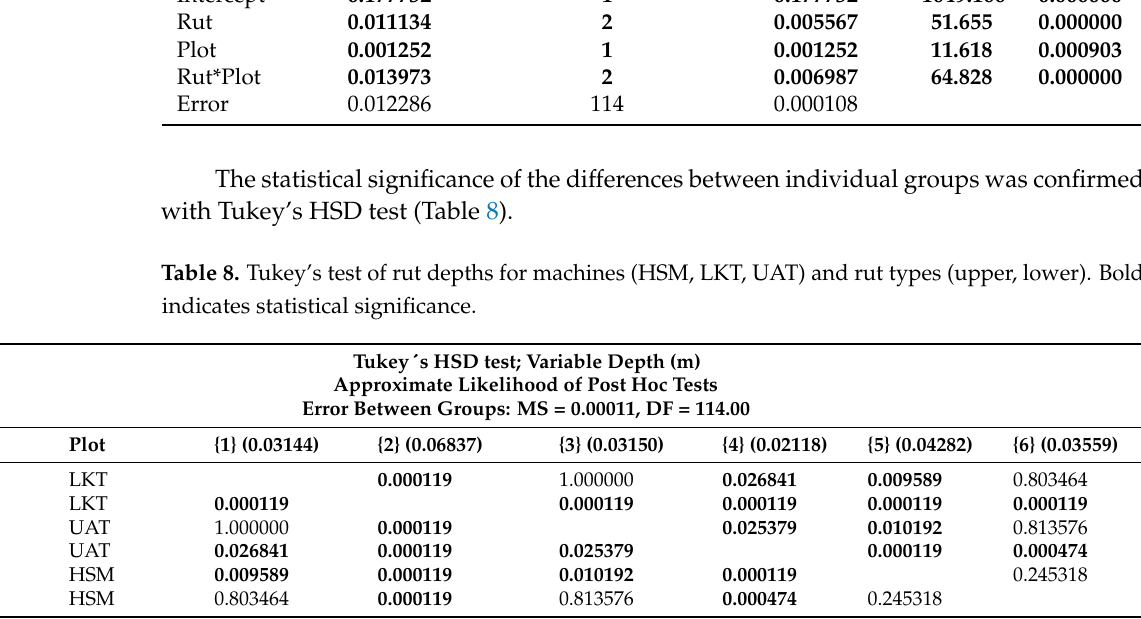
Table 9. Calculated volumes (m 3 ) for individual plots and various passes of machines.